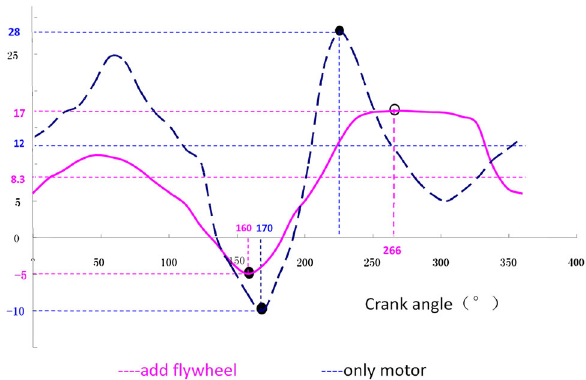
Fig. 15 Comparison of motor power curve with and without flywheel-energy-storage device (Zhao and